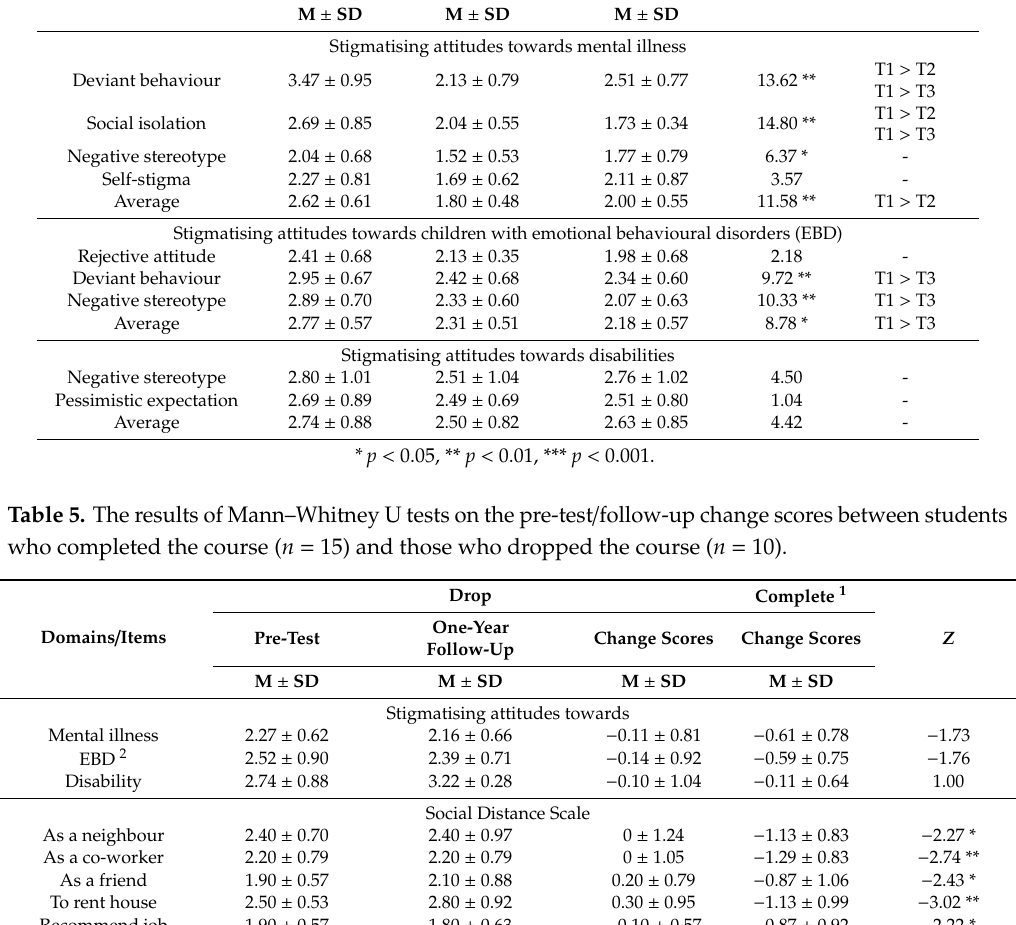
Table4. TheresultsofFriedmantestonthepre-test, post-test, andfollow-upscoresforthequestionnaires on stigmatising attitudes among students who completed the course ( n = 15).